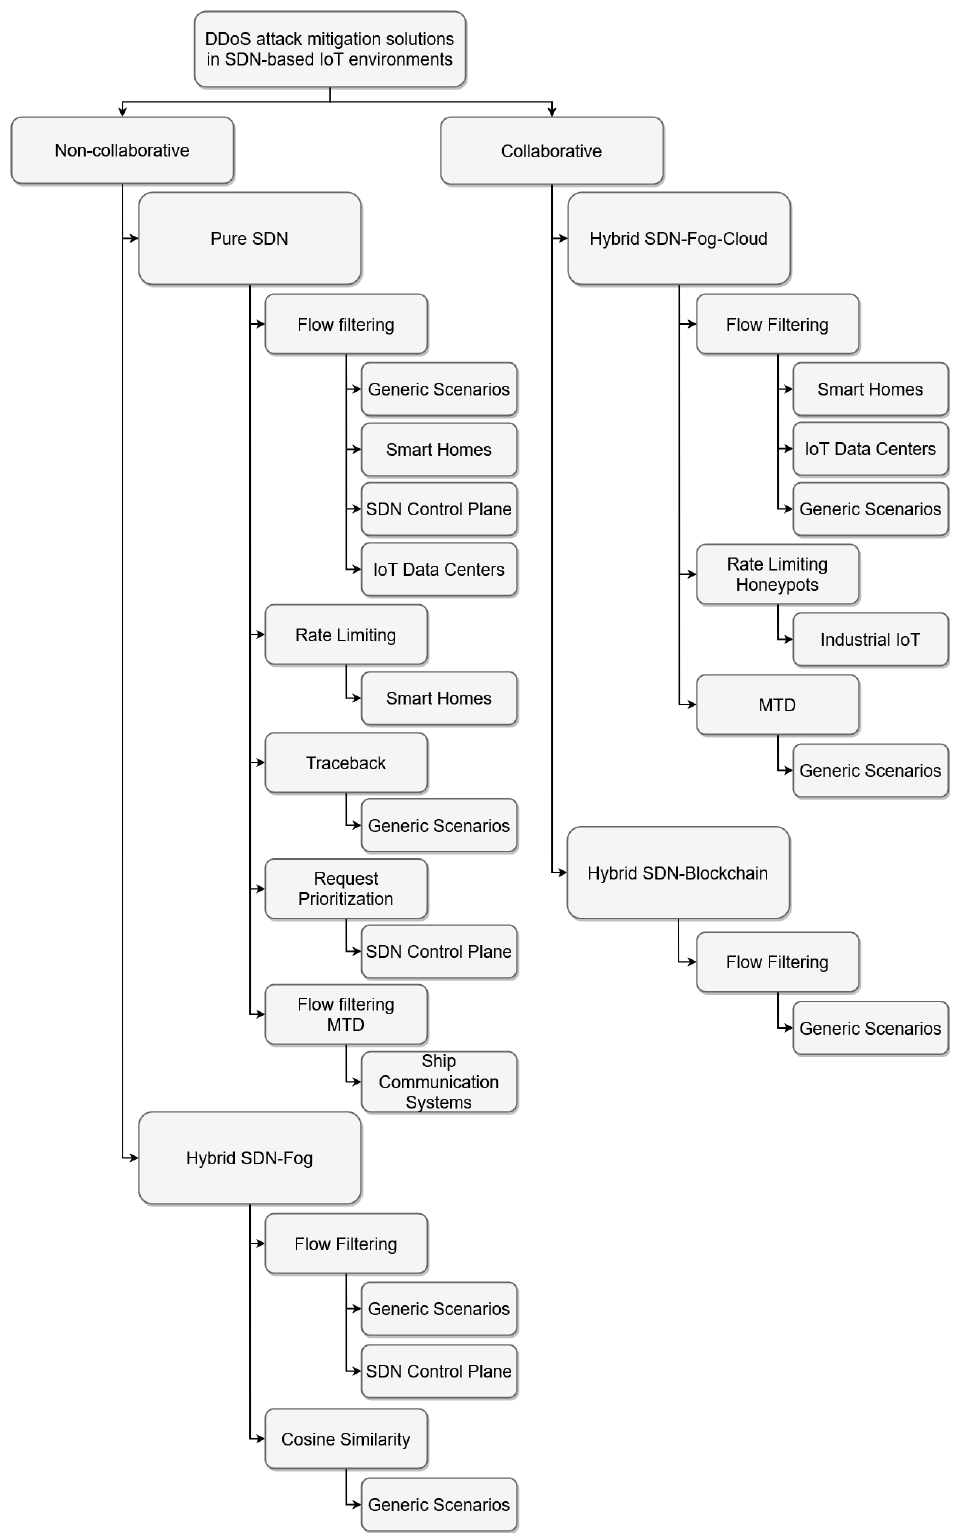
Figure 2. Proposed